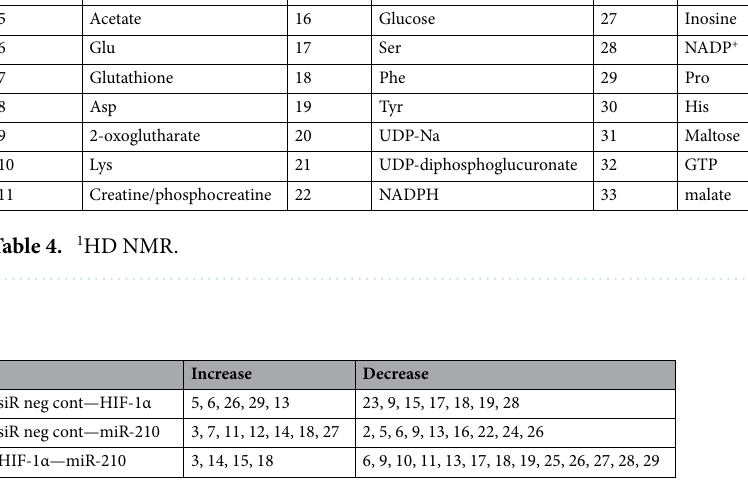
Table 5. Change in total value of metabolites in analysed groups (based on Table 4).